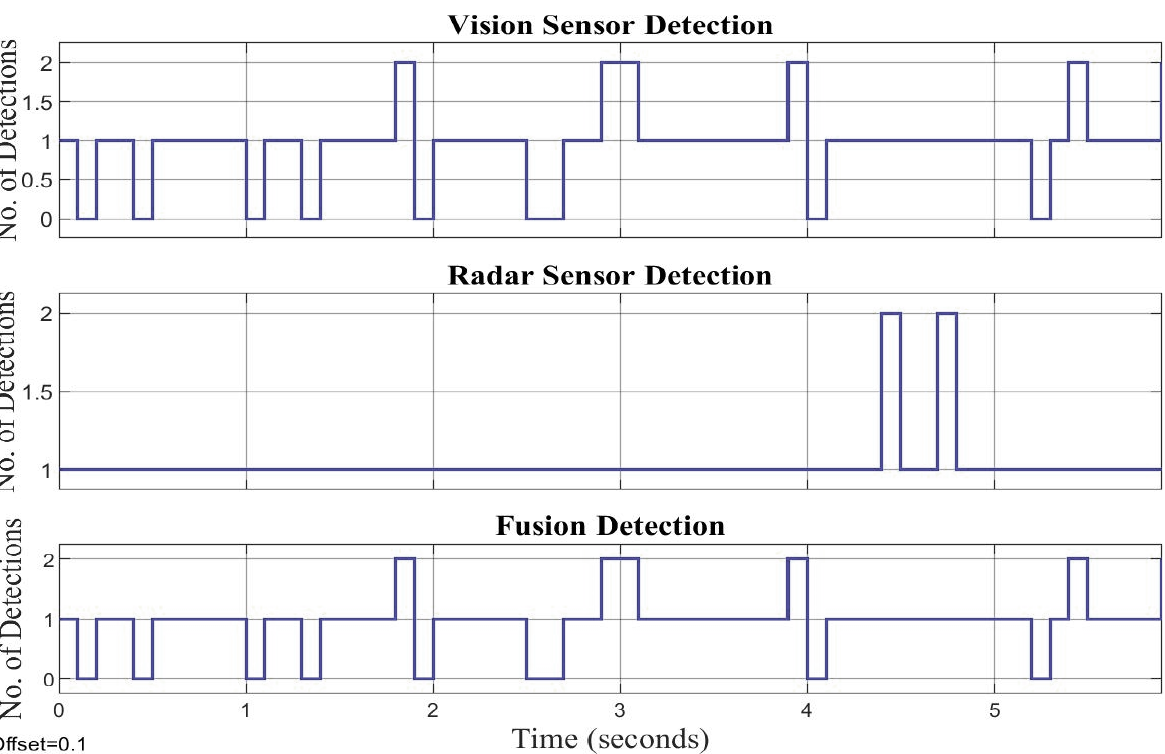
Figure 22. Results of earlier sensor fusion technique when using two sensors. Table 2. Detail properties of radar, vision, lidar, proposed fusion, and previous fusion.